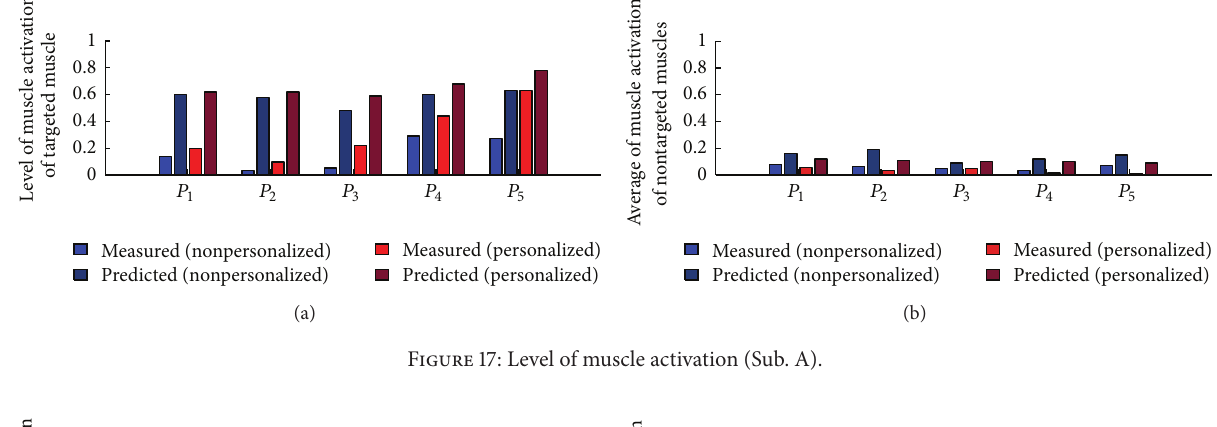
Figure 17: Level of muscle activation (Sub. A).